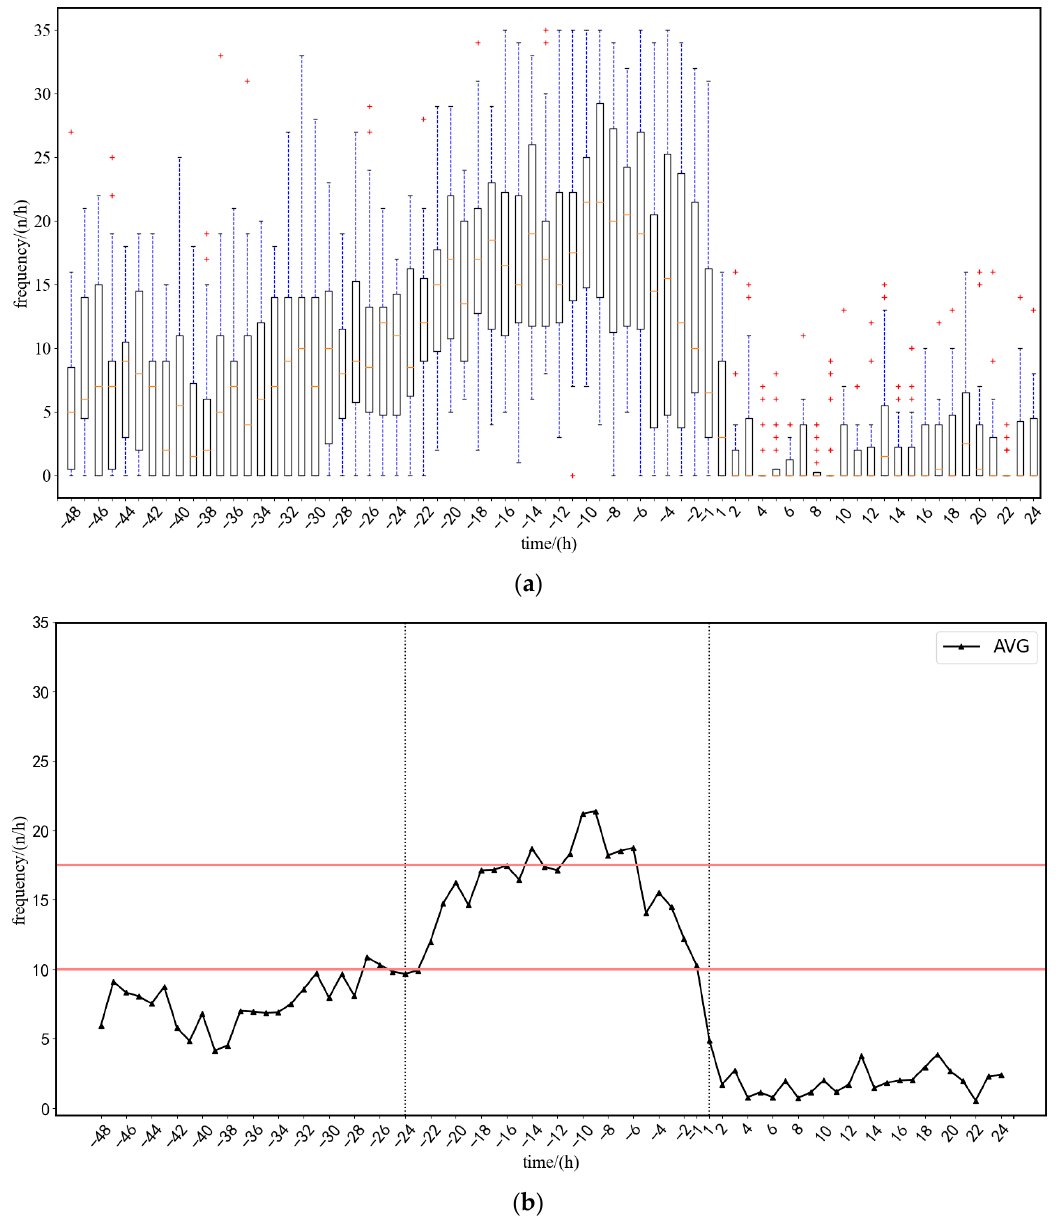
Figure 12. Range and mean of sow per hour posture change frequency (results of 22 sows statistics). ( a ) Frequency range of sow posture change per hour. ( b ) Mean frequency of sow posture change.